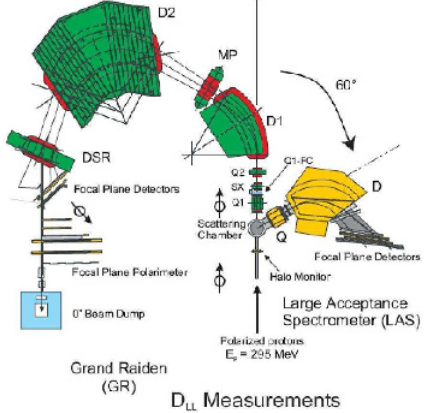
Fig. 3. (color online) The experimental setup at the RCNP in Os- aka as it has been used for the D LL measurement [9]. For the D NN measurement the DSR Magnet has been used for rotating the spin of the